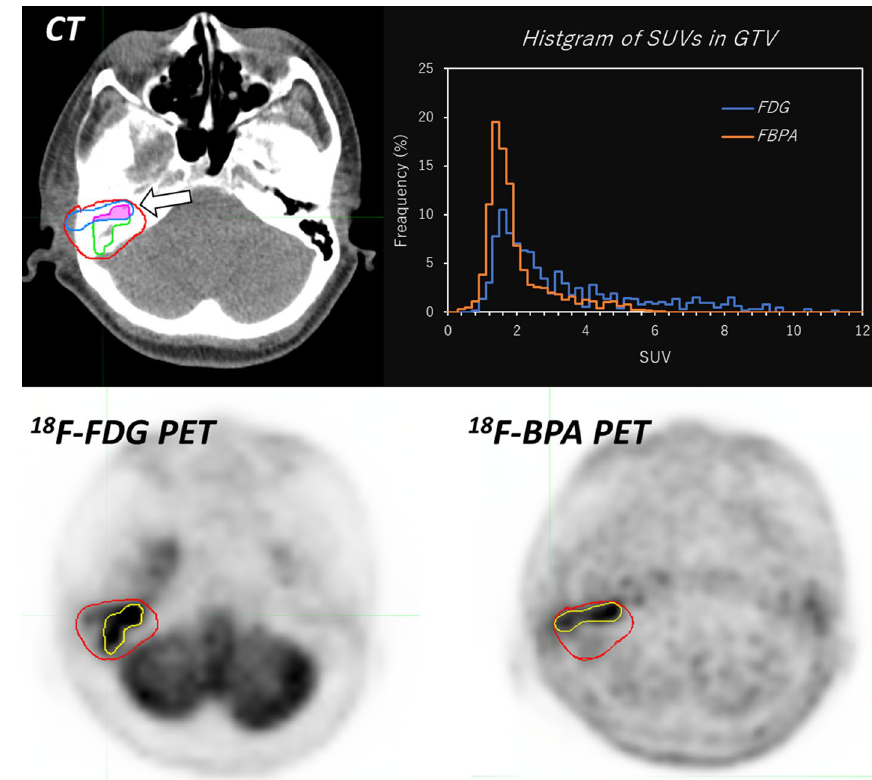
Fig. 4 The example images of measure similarities (DSC, JC, and MDA) and histogram indices (skewness and kurtosis). The red and yellow lines on PET images (bottom images) show the contour of GTV and MTV40 on each PET image, respectively. The white arrow on the CT image indicates the overlap region between MTV40 on 18 F-FDG and that on 18 F-BPA PET. The overlap volume is used to calculate DSC and JC. The top right image shows histograms of SUVs derived from GTVs on both PET images for the calculation of skewness and kurtosis